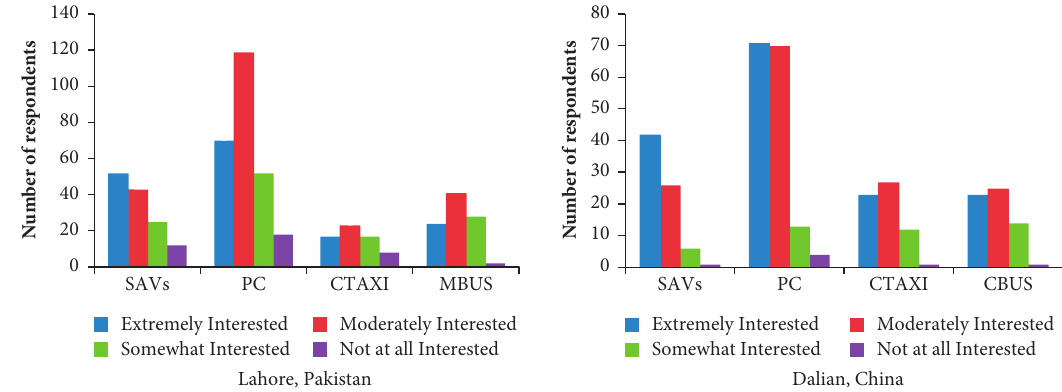
Figure 7: Preferences of automation interested individuals to social